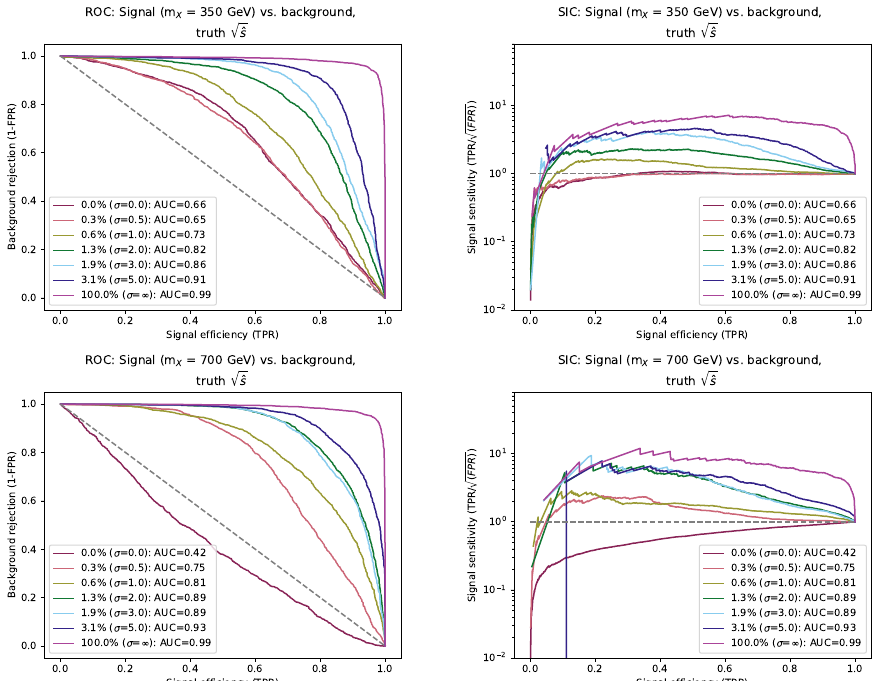
Figure 6. Weakly supervised training results in the form of ROC (left) and SIC (right) curves for two signals, m = 350 GeV (top) and m = 700 GeV (bottom) vs. background. The dashed X X grey line indicates no improvement from the use of the neural network score. A significance of ∞ indicates the case of pure signal versus pure